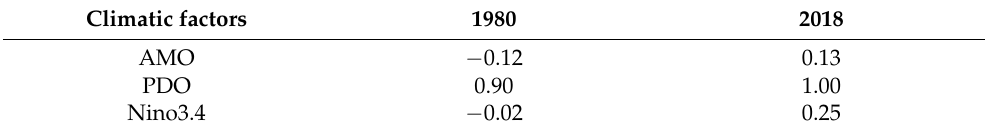
Figure 2. Temporal characteristics of annual average in AMO, PDO and Nino3.4 (The black line is the annual evaluation and the blue line is the fitting line for the losses function). Table 2. 1980–2018 Annual average change in AMO, PDO and Nino3.4. Climatic